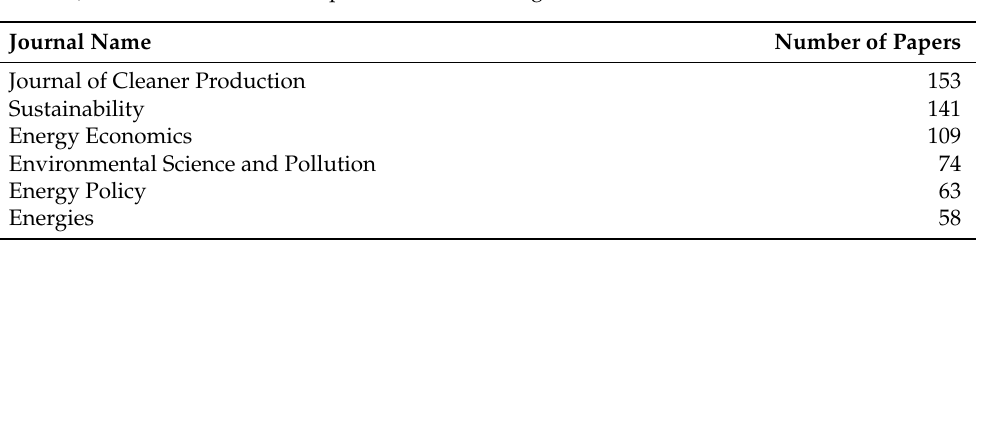
Table 1. Journals with 50 or more publications covering our search